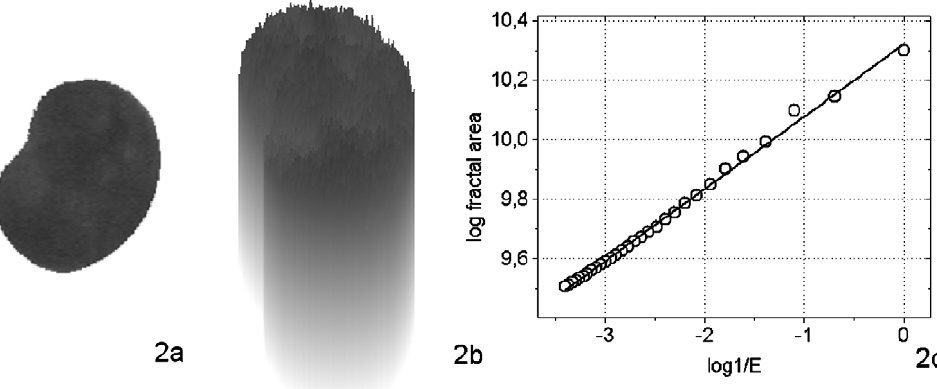
Fig. 2. Leukemic blast (a) with relatively smooth surface in the pseudo-3D representation of the chromatin (a) and good approximation of the curve by a linear regression in the log–log-plot ( R 2 = 0 . 997;